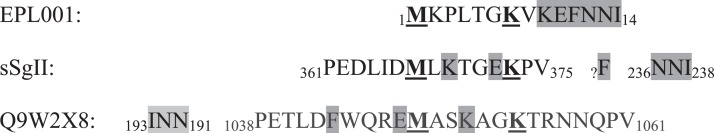
Sequence alignment of MxxxxxK doubletons.Doubleton in synthetic antigen EPL001, with matches in endogenous candidate antigens—SgII-related in mammals, Q9W2X8 in the fruit fly—with residues shaded having proposed relevance to the epitope of the anti-EPL001 antibody.